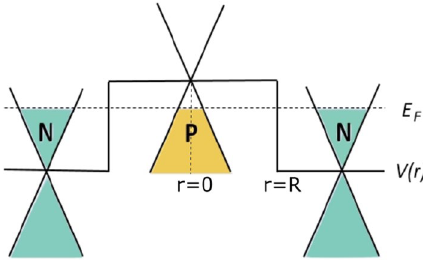
Figure 1. Energy band of an NPN-type graphene quantum dot with Fermi energy E F and potential V ( r ). Quasi- bound states are formed in section P , and the substrate is section N , where the V ( r ) is higher in section P than in section N